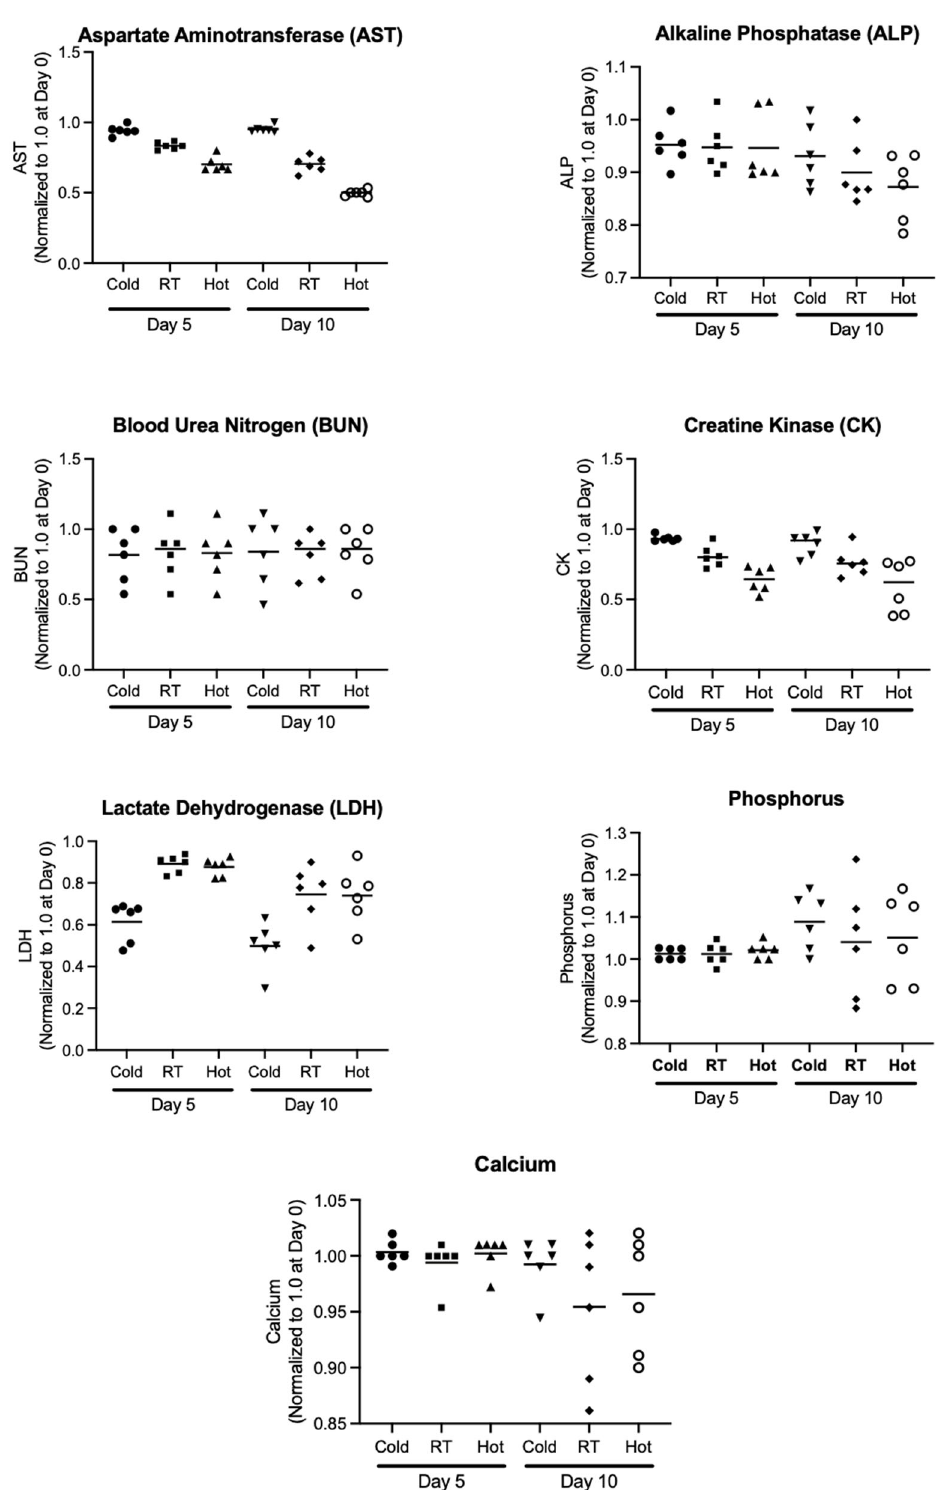
Figure 1. Serum biochemical analytes (AST, ALP, BUN, CK, LDH, phosphorus, and calcium) of African savanna elephants with significant changes ( p -value ≤ 0.05) when stored at 2.2 ◦ C (“Cold”), ~23 ◦ C (Room Temperature, “RT”), or 32.2 ◦ C (“Hot”) and then analyzed at Day 5 and Day 10 post-collection. Data were normalized to Day 0 (control group) by converting the biochemical values to percentages using Day 0 values designated as 1.0. Each data point represents a result from one of the six elephants for each storage condition. Each test condition is represented by a different data point shape to allow easy differentiation of test groups in the graphs. The linear bars represent the